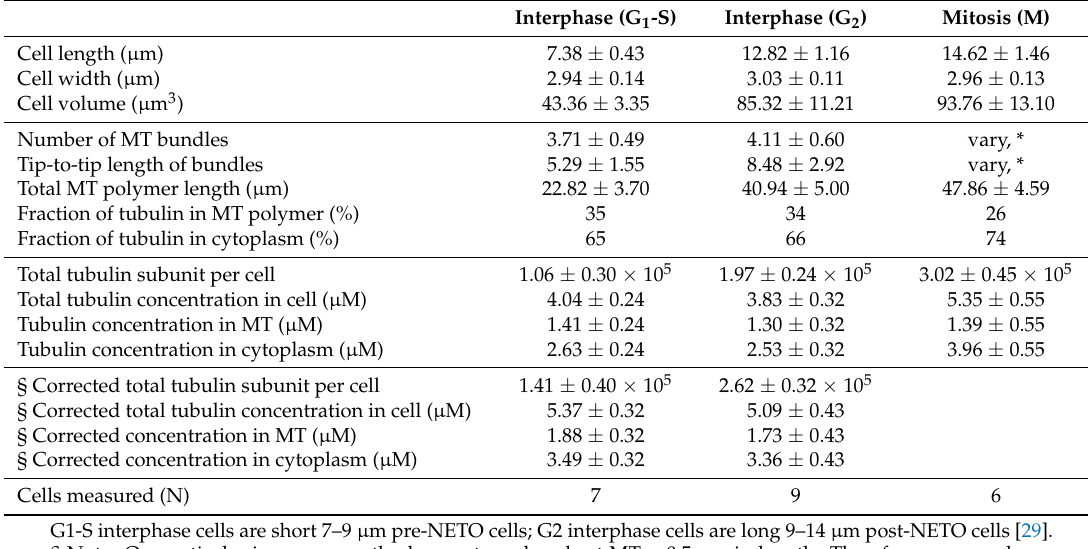
Table 1. Tubulin concentrations in interphase and mitotic wild-type